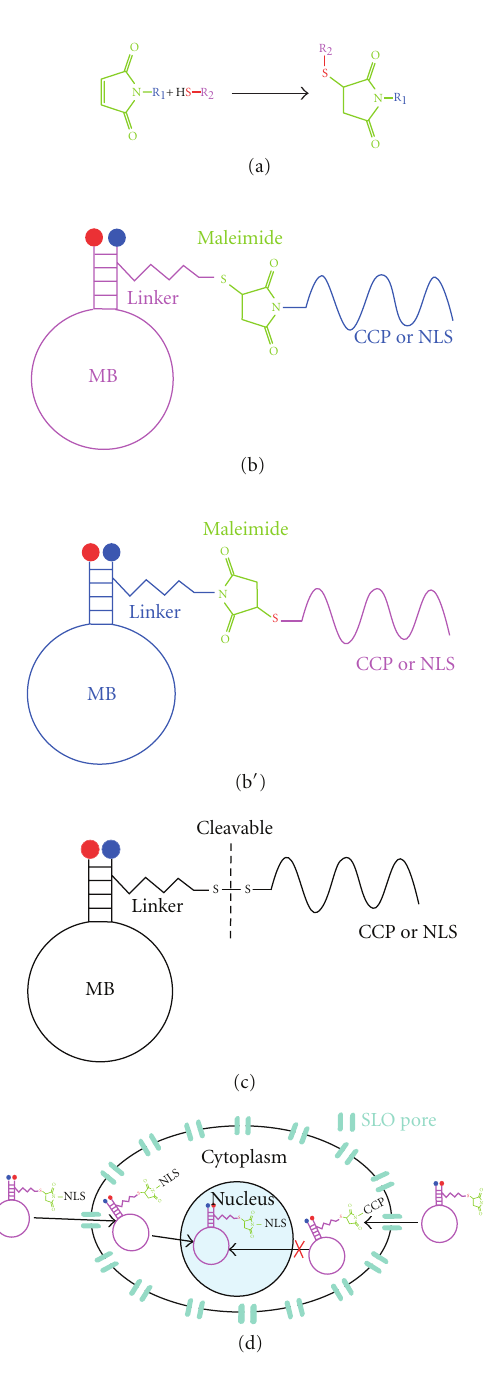
Figure 4: MB linked to penetrating peptides. (a) Reaction of conjugation among the maleimide molecule with a carrier group (R 1 ) and the thiol group of another molecule. This reaction may possibly link MB-peptide and occurs at a pH between 6.5–7.5. (b) One possibility using the maleimide-thiol system is that the peptide (NLS or CCP) it is linked to the maleimide across the secondary amine and reacts with a sulfhydryl group at the terminus of the MB hydrocarbon linker. (b (cid:2) ) The other possibility for the maleimide-thiol system is that the maleimide is linked at the terminus of the MB hydrocarbon linker and reacts with a thiol group at the peptide (NLS or CCP). (c) The link between the hydrocarbon linker of the MB and the peptide also could be across a disulphide bridge, in this case exists the possibility to cleave the bond in a reducing environment. (d) Using SLO to make permeable the cytoplasmic membrane is possible to introduce a MB linked to an NLS peptide to the cytoplasm with the objective that it be transported into the nucleus by the cellular machinery. For a CCP-linked MB the entrance to the nucleus is